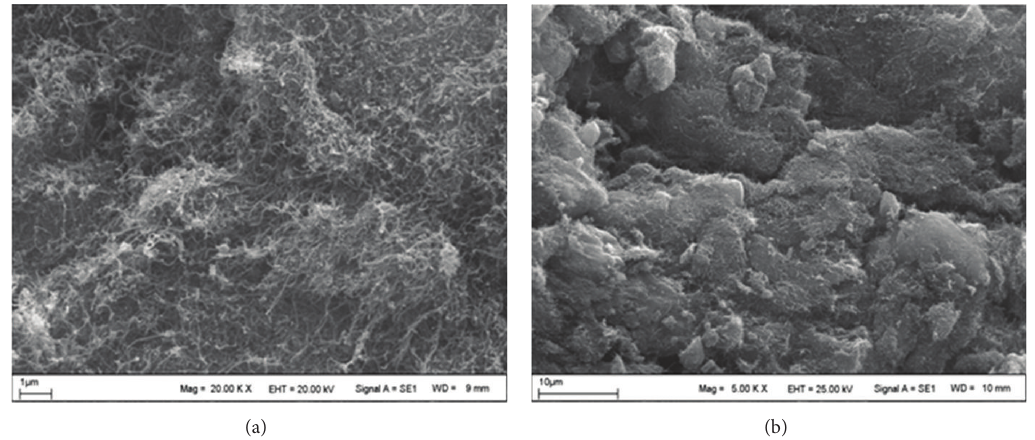
Figure 7: SEM images of MWCNT-COOH (a), PEA-MWCNT (b).